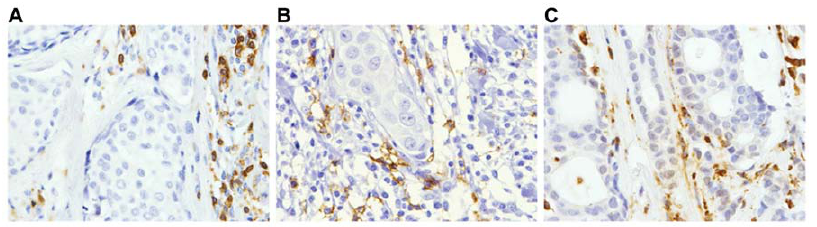
Figure 1. Representative examples of immunohistochemical stainings at the invasive front from breast carcinomas ( 6 200 magnification). (A) Membranous staining of CD3 indicating T-lymphocytes. (B) Membranous staining of CD20 indicating B-lymphocytes. (C)